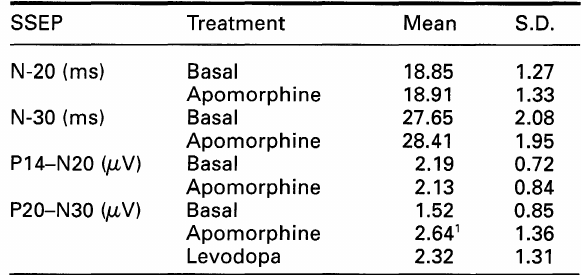
TABLE I. Mean latencies and amplitudes of parietal and frontal potentials in the basal condition ('off state') and after apomorphine or